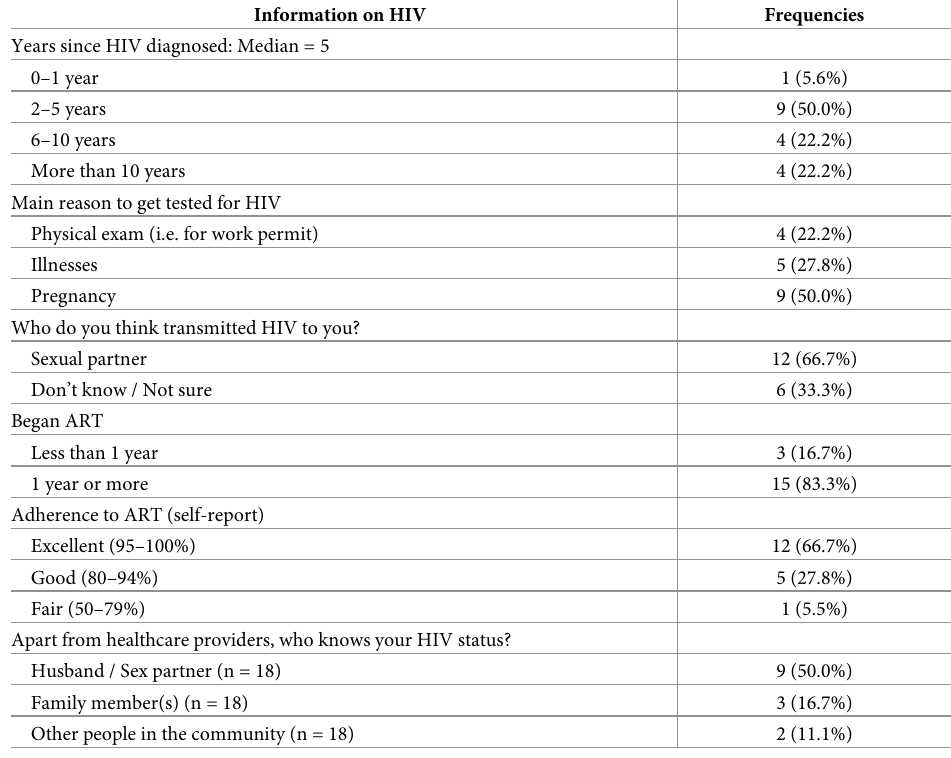
Table 3. HIV information of female Shan living with HIV (N =